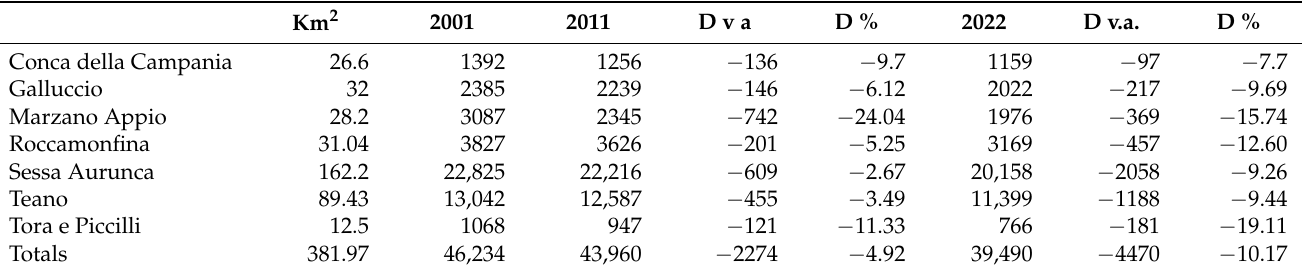
Table 8. Campania Region. Regional Park Volcanic Area of Roccamonfina and mouth of Garigliano, municipal surface area, population and population variations in absolute and percentage values (processing by Antonio Bertini on Istat data).